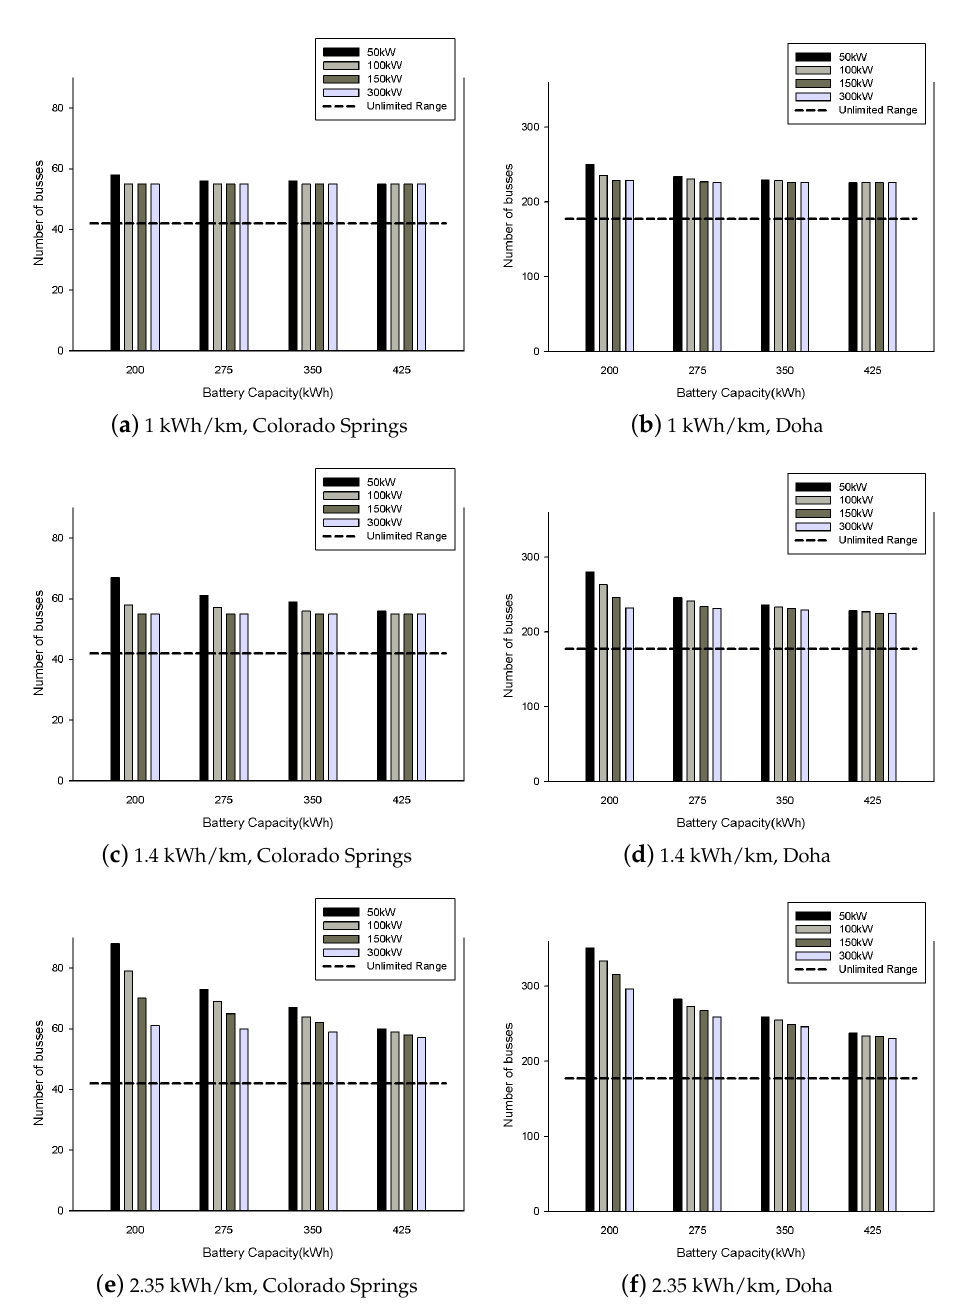
Figure 7. Number of EBs with different ranges dependent on depot charging power to achieve a large public bus transport system. In each of the subfigures the dashed line corresponds to the number of DBs needed for the same